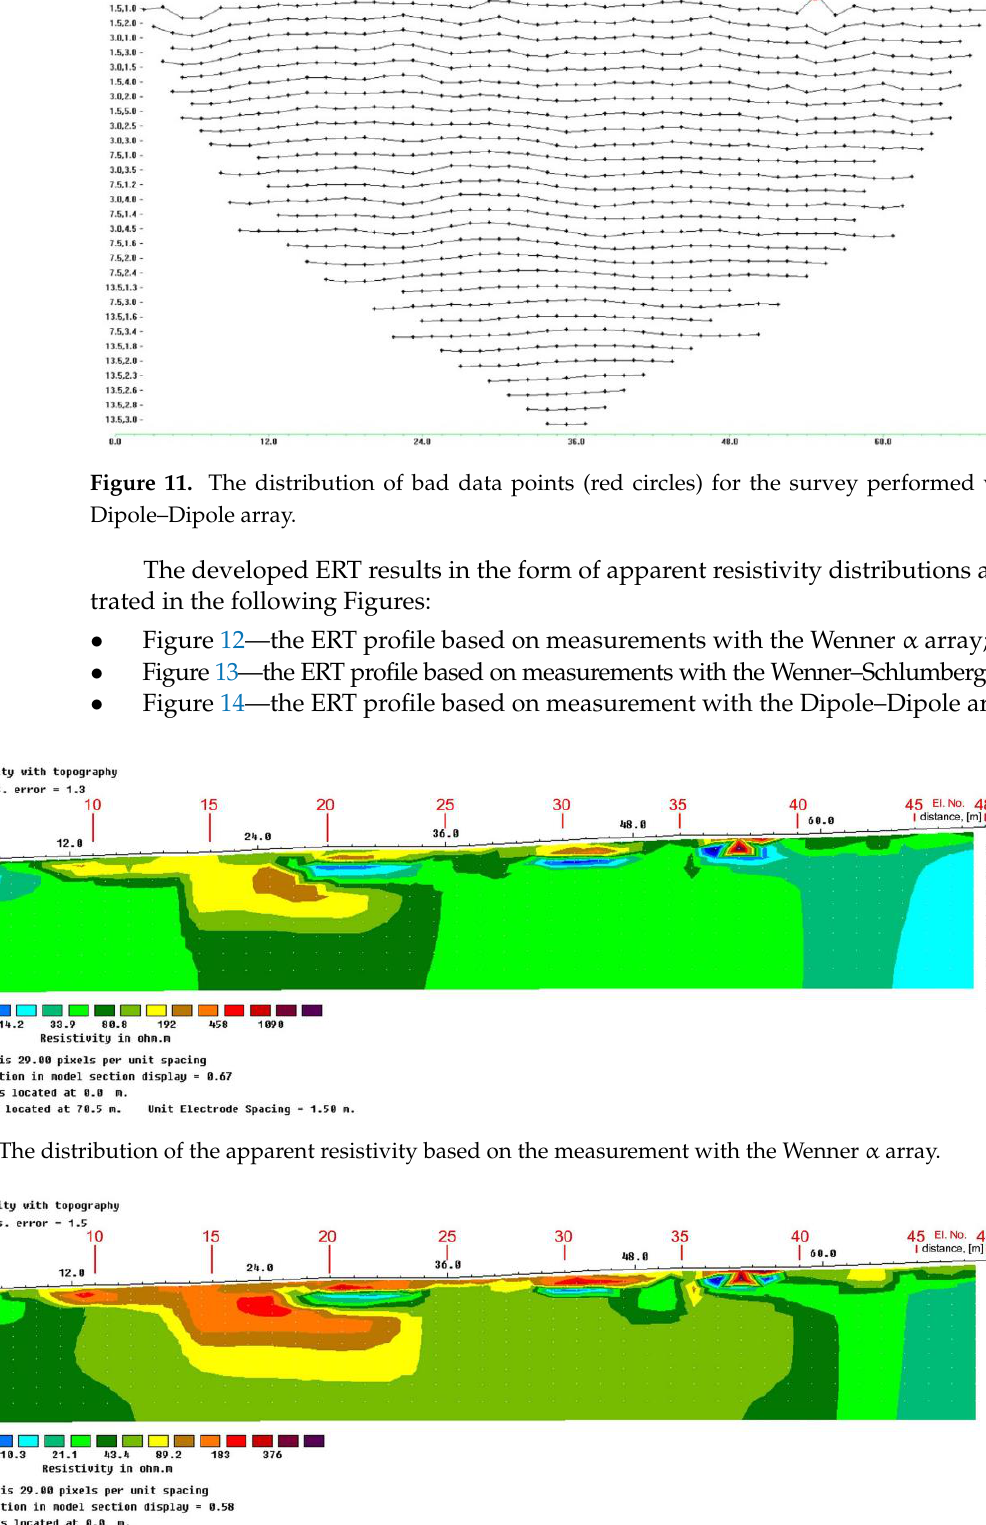
ner–Schlumberger array.